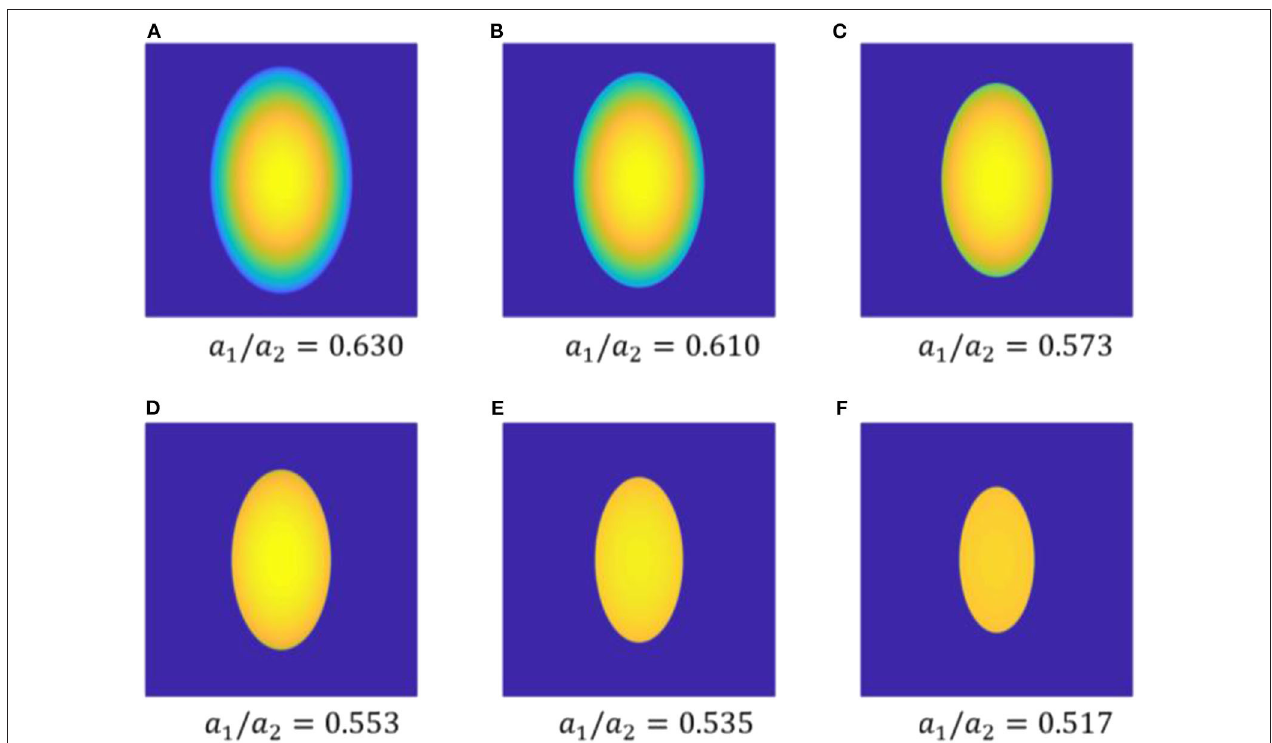
FIGURE 6 | Distributions of normal pressure of the contact between an elliptical indenter and a soft substrate with modulus E * = 10 kPa and different membrane/surface tension: (A) τ 0 = 0 N/m, (B) τ 0 = 0.1 N/m, (C) τ 0 = 0.5 N/m, (D) τ 0 = 1 N/m, (E) τ 0 = 2 N/m and (F) τ 0 = 5 N/m.